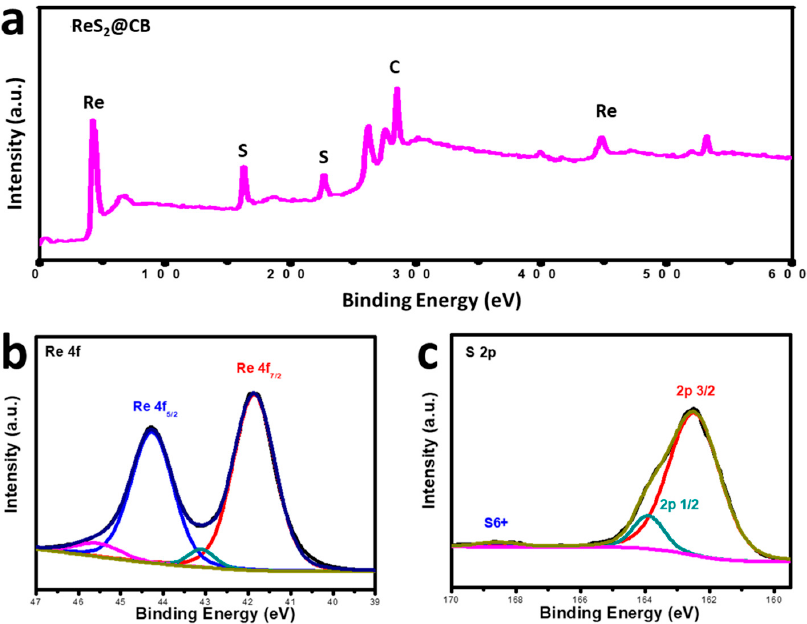
Figure 4. XPS spectra of the ReS 2 @CB: survey spectra ( a ), and high-resolution spectra of Re 4f ( b ) and S 2p ( c ).